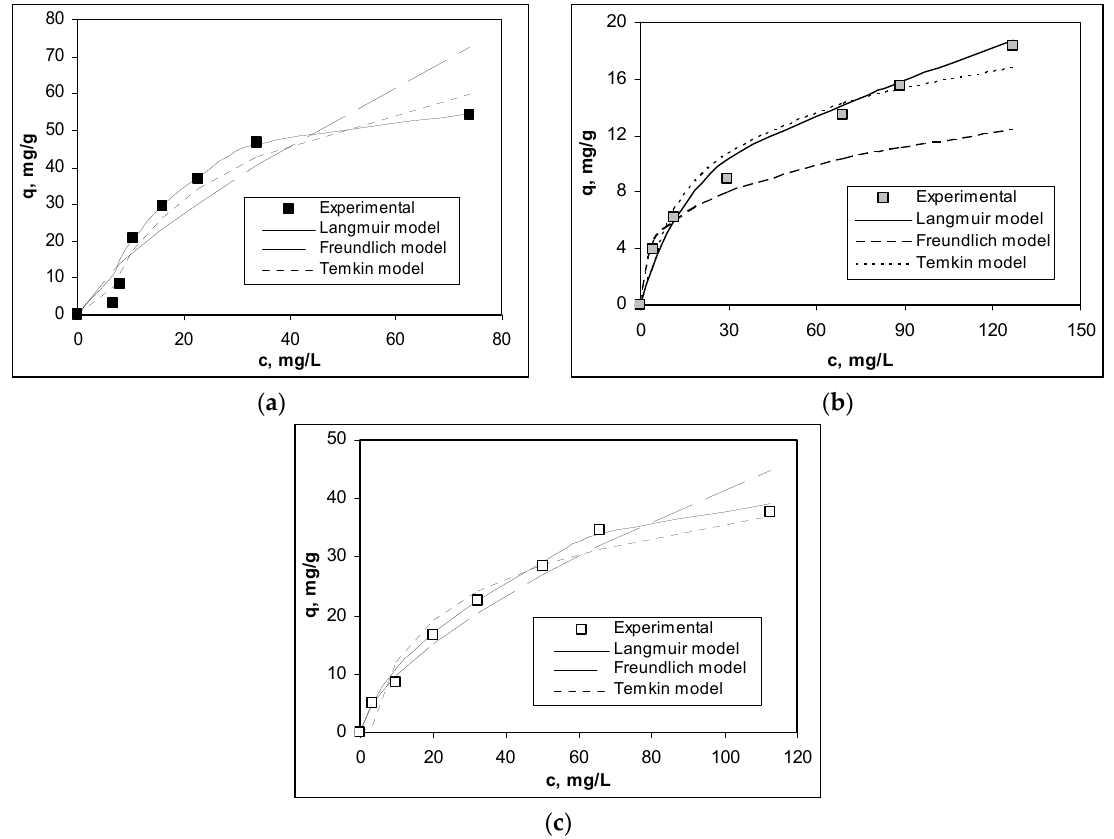
Figure 8. Experimental and theoretical isotherms obtained for the biosorption of ( a ) Cu(II) ions, ( b ) Co(II) ions and ( c ) Zn(II) ions on alginate.(Experimental conditions: pH = 4.4; biosorbent dosage = 2.0 g/L; temperature = 22 °C).